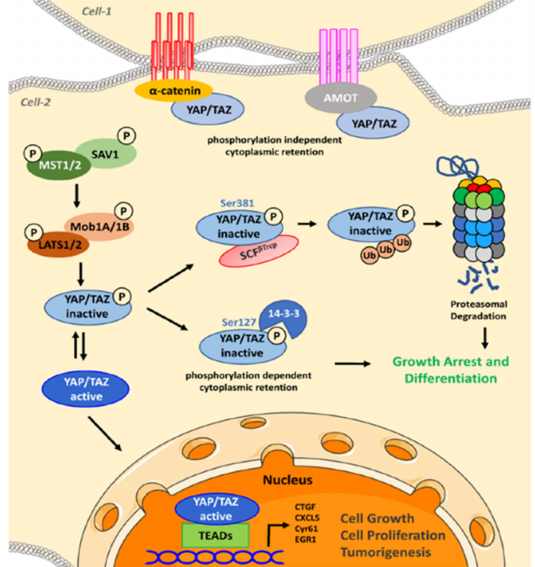
Figure 1. Regulation of YAP/TAZ activity. The YAP/TAZ transcription co-activator is the main downstream effector of Hippo kinase cascade signaling. LATS1/2-mediated YAP-phosphorylation (YAP inactive, negative feedback) induces its cytoplasmic retention or degradation via proteasome, while YAP, not phosphorylated (YAP active), is able to translocate into the nucleus and to acti- vate the transcription of oncogenic YAP-responsive target genes by the interaction with TEAD transcription